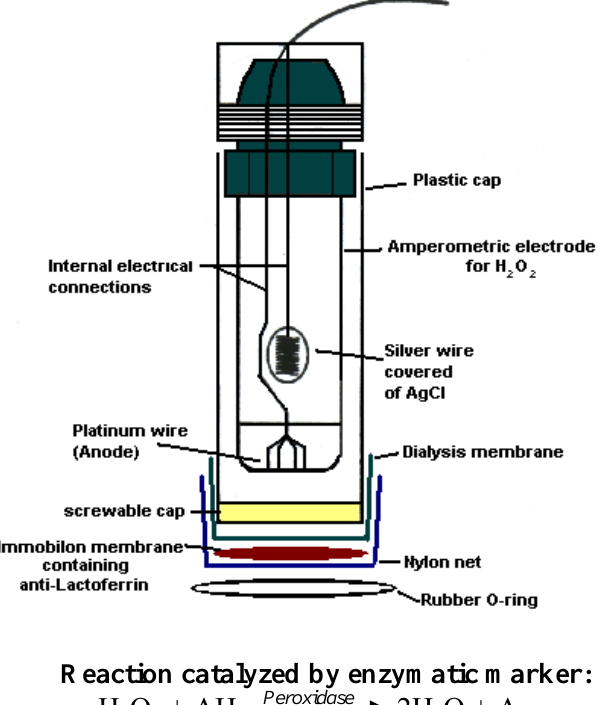
Figure 2. Amperometric immunosensor for lactoferrin determination using hydrogen peroxide electrode as